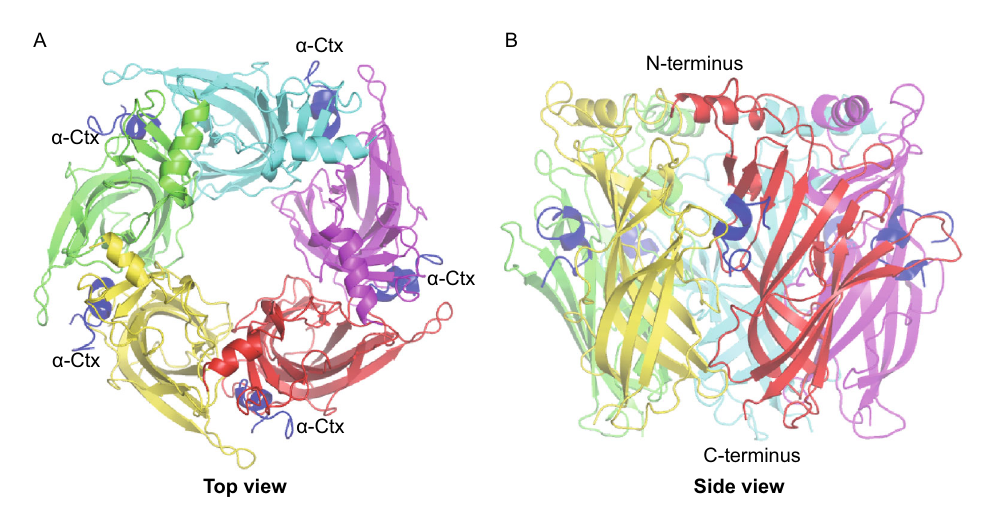
Figure 1. The X-ray crystal structure of α -conotoxin LvIA binding to Ac-AChBP. (A) The top view of Ac-AChBP/LvIA structure, showing LvIA (blue) in fi ve binding sites. (B) The side view of Ac-AChBP in complex with LvIA, two adjacent protomers of the pentamer with a bound α -conotoxin LvIA molecule (in blue).